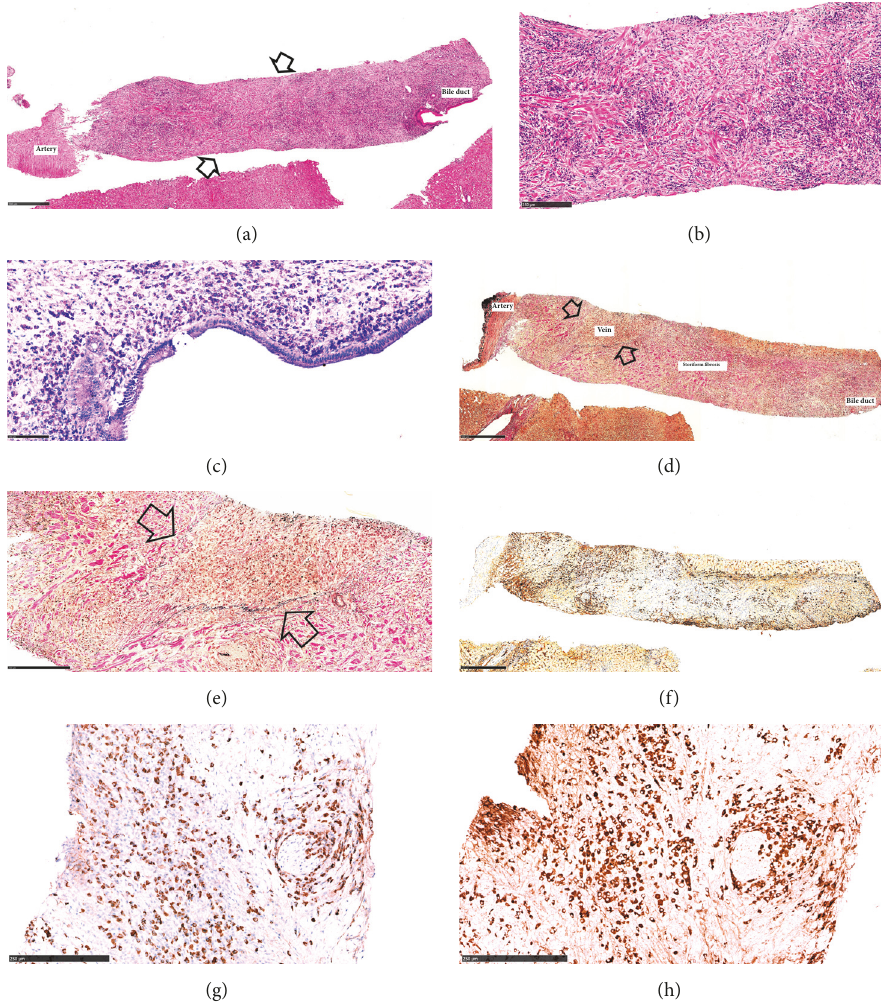
Figure 2: Liver core needle biopsy findings in a patient with IgG4-related sclerosing cholangitis (IgG4-SC). (a) A portal inflammatory nodule (IN),showingstoriformfibrosis(arrows)anddiffuselymphoplasmacyticinfiltration(H&E).(b)Highermagnificationofthestoriformfibrosis (H&E). (c) Strong infiltration of lymphocytes and plasma cells in the wall of the bile duct (Methyl-Green Pyronin). (d) Deeper section of the same area shown in Figure 2(a). At the periphery of the IN, there is obliterative phlebitis (arrows). Note the wall of the corresponding artery (Verhoeffelastin). (e) Higher magnification of the area with obliterative phlebitis shown in Figure 2(d). The former lumen of the vein is filled with plasma cells and lymphocytes. The vein can only be identified using an elastin stain (Verhoeff elastin). (f) Deeper sections of the area shown in Figure 2(a). Strong infiltration of IgG4-positive cells in the IN. (g, h) The IgG4 / IgG ratio is 72%.